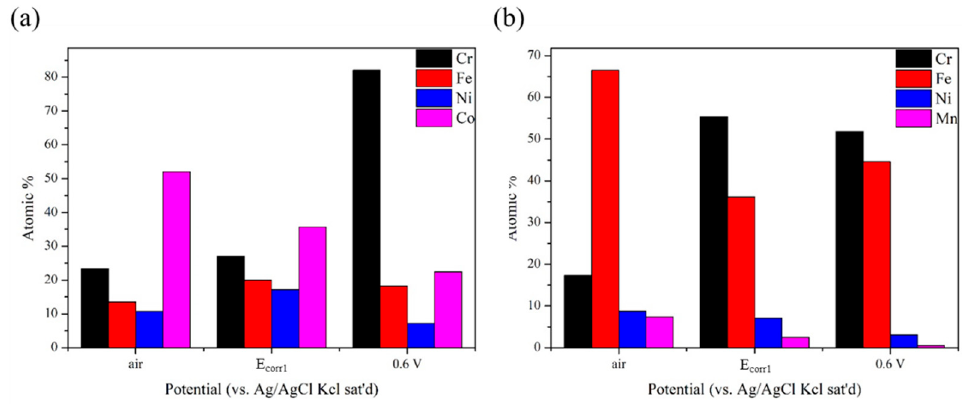
Figure 6. The atomic proportion variations (within 0.5% error) of metal elements in the passive films formed in air, at E corr 1 and 0.6 V for ( a ) CoCrFeNi HEA and ( b ) 304SS specimens, derived from XPS. Figures 7 and 8 show the detailed XPS results of Cr 2p 3/2 , Fe 2p 3/2 , Ni 2p 3/2 , Co 2p 3/2 , Mn 2p 3/2 , and O 1s for the CoCrFeNi HEA and 304SS passivation films in the air, at E corr1 and at 0.6 V passivation potential in 0.5 M H 2 SO 4 AAS respectively. In Figures 7a and 8a, the Cr 2p 3/2 ionization is separated into several constituent peaks representing the metallic Cr 0 (574 eV), Cr 2 O 3 (576.1 eV), and Cr(OH) 3 (577.2 eV). Element Cr in 304SS and CoCrFeNi HEA is primarily passivated to chromium hydroxide and oxide in 0.5 M H 2 SO 4 AAS. Fig- ures 7b and 8b show that the Fe 2p 3/2 ionization is split into several constituent peaks rep- resenting the metallic Fe 0 (706.7 eV), Fe/Ni (707.2 eV), Fe 3 O 4 (708.1 eV), FeO (709.6 eV), Fe 2 O 3 (711.6 eV) and Fe(OH)O (711.9 eV). In Figure 7b at − 0.18 V, more Fe in the CoCrFeNi HEA is oxidized to Fe(OH)O earlier than 304SS, due to the higher E corr1 of the former. The ferric states in both films are the main components of the iron at 0.6 V, resulting in the stable passivation regions. As shown in Figures 7c and 8c, the Ni 2p 3/2 spectra are split into three constituent peaks representing the metallic Ni 0 (852.7 eV), NiO (853.6 eV), and Nisat (858.6 eV). The results show that the nickel on both alloys is not further oxidized to high- valence nickel such as Ni 2 O 3 or NiO 2 for reducing the solubility of nickel in 0.5 M H 2 SO 4 AAS. In Figure 7d, not similar to iron, just a small part of cobalt on CoCrFeNi HEA is further oxidized into Co(OH)O at 0.6 V, a smaller k sp that can also increase the corrosion resistance, revealing the enhanced passivation at potentials higher than 0.6 V. Peaks of MnO (640.8 eV) are observed on 304SS in air and at E corr1 ( − 0.35 V), then further oxidized into Mn 3 O 4 , Mn 2 O 3 and MnO 2 , as shown in Figure 8d, basically compliant with reactions (12), (13) and (15). The O 1s spectra are separated into two or three peaks, as shown in eV represents the metal hydroxides and the peak at 532.8 eV corresponds to a little H 2 O